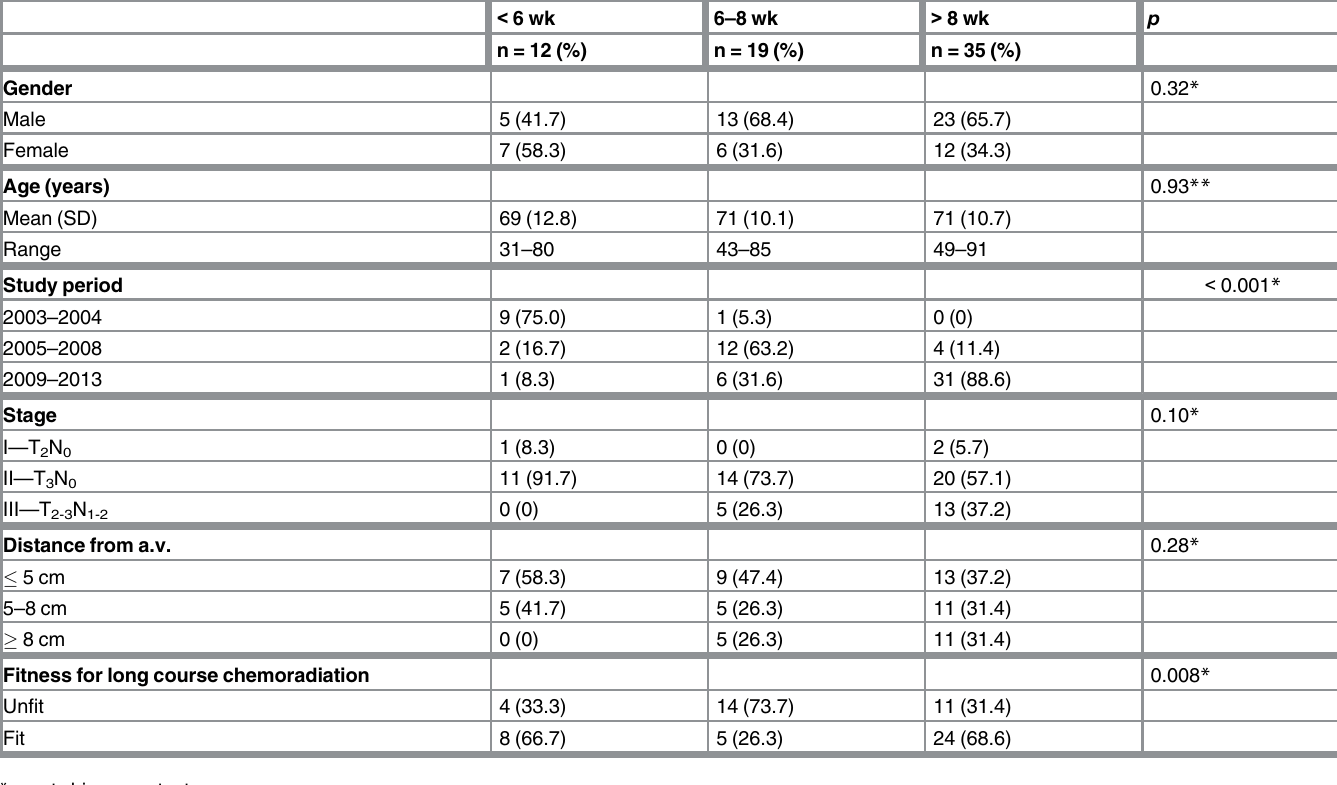
Table 1. Baseline characteristics of the patients grouped according to interval to